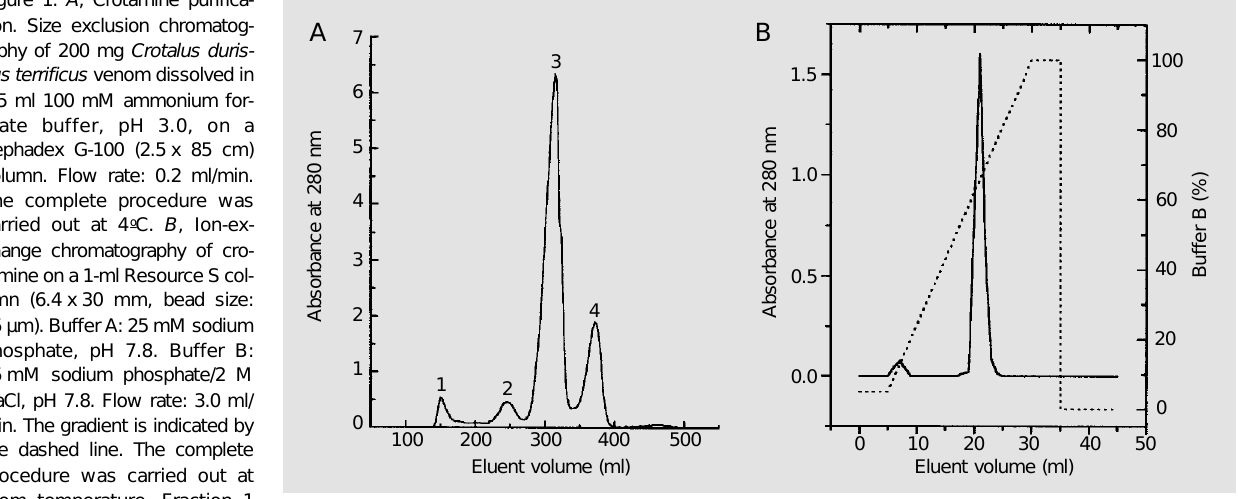
Figure 1. A , Crotamine purifica-